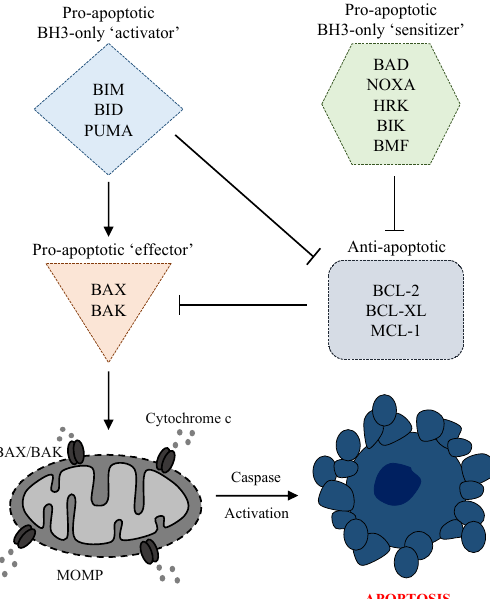
Figure 1. The intrinsic apoptosis pathway is tightly regulated by pro- and anti-apoptotic BCL-2 proteins which interact on the mitochondrial outer membrane. Pro-apoptotic BCL-2 proteins can be subcategorized as BH3-only ‘activators’ (BIM, BID, PUMA), BH3-only ‘sensitizers’ (BAD, NOXA, HRK, BIK, BMF) and pore-forming ‘effectors’ (BAK, BAX). Counteracting these are anti-apoptotic/pro-survival BCL-2 proteins including MCL-1, BCL-2, BCL-XL which sequester pro-apoptotic BCL-2 family members. BH3-only ‘activators’ promote apoptosis by directly engaging and activating BAX/BAK, as well as sequestering anti-apoptotic BCL-2 proteins. BH3-only ‘sensitizers’ are unable to directly engage BAX/BAX and primarily function by sequestering anti-apoptotic members. The induction of BH3-only proteins in response to cell death stimuli can trigger BAX/BAK homo-oligomerization, the formation of macropores, mitochondrial outer membrane permeabilization (MOMP), the release of cytochrome c and caspase driven apoptotic cell death. A range of cellular stress and cell death stimuli, such as DNA damage (including that from DNA-targeting anti-cancer agents and radiation), replication stress, growth factor BH3-only ‘activator’ and/or ‘sensitizer’ proteins via transcriptional upregulation or post- translational modification [57,69]. For example, p53 induces PUMA and NOXA mRNA transcription in response to DNA damage, thereby priming the cell for apoptosis